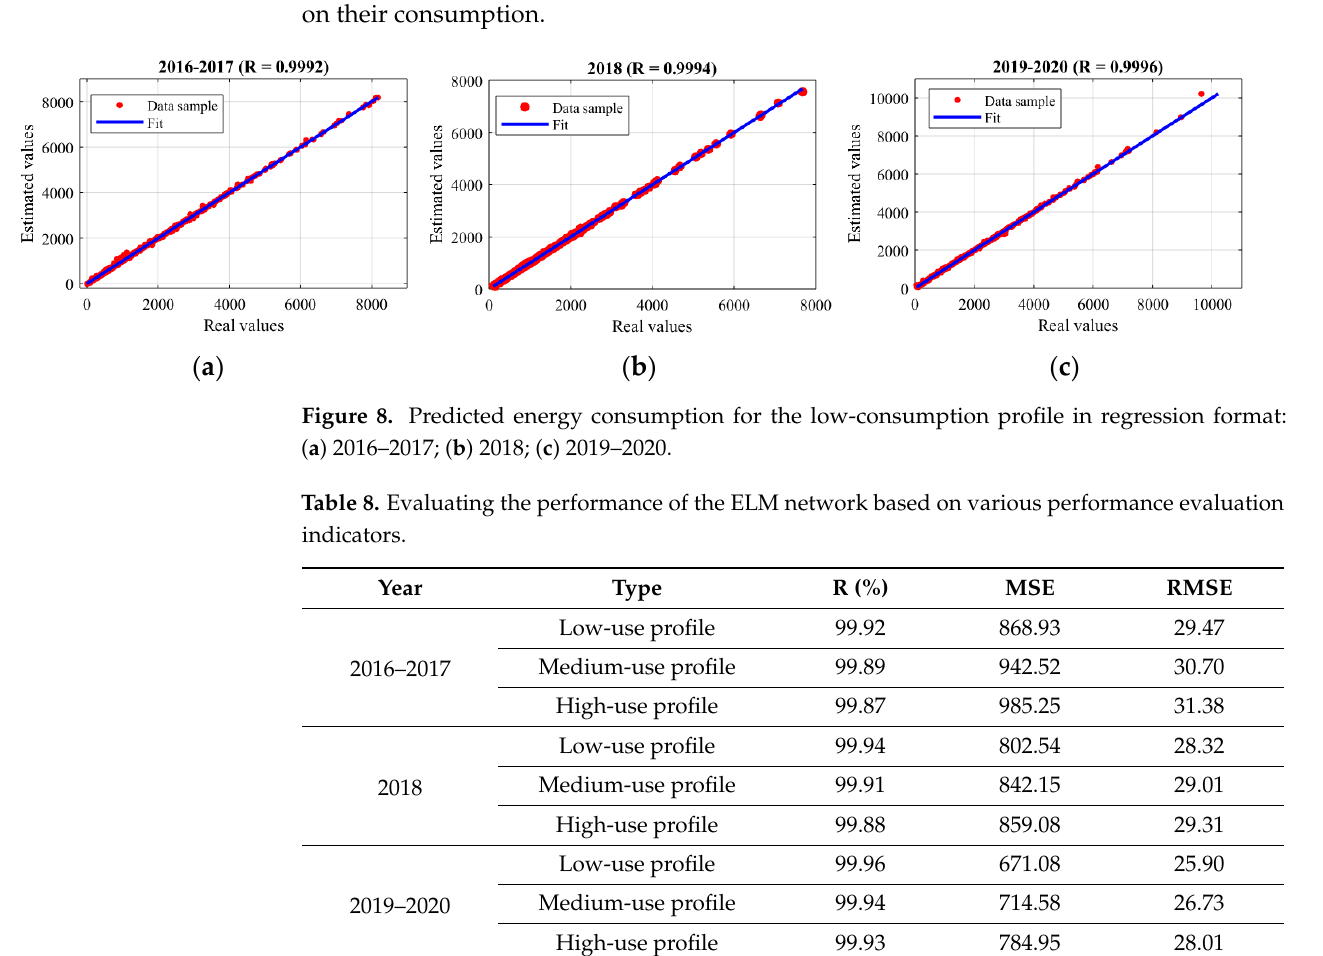
Figure 7. Step-by-step implementation process of the ELM technique.